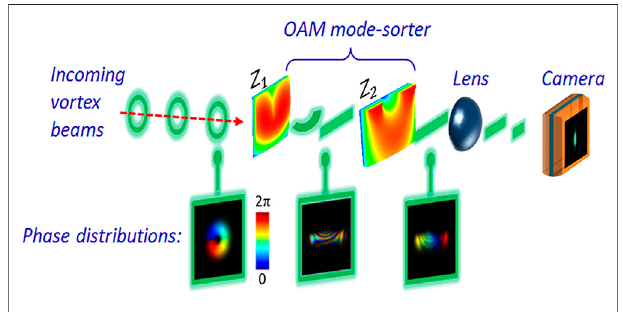
FIGURE 2 | Schematic illustration of the mode-sorter as incoming l = 1 OAM mode propagates through the elements. Additional phase and intensity pro fi les are presented at certain locations with respect to the two elements.